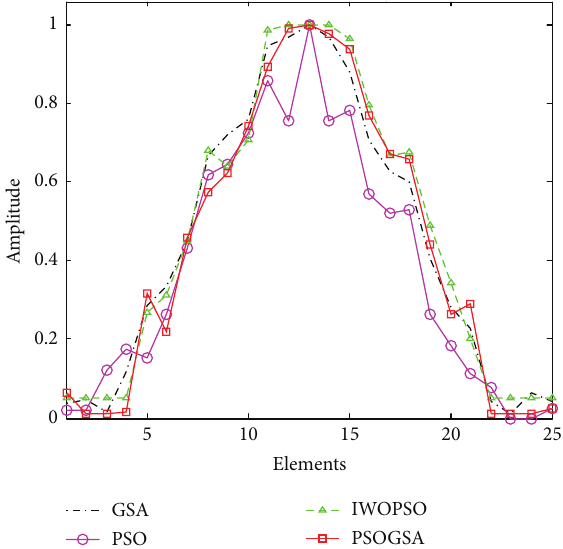
Figure 6: Element amplitude distribution for half-circle